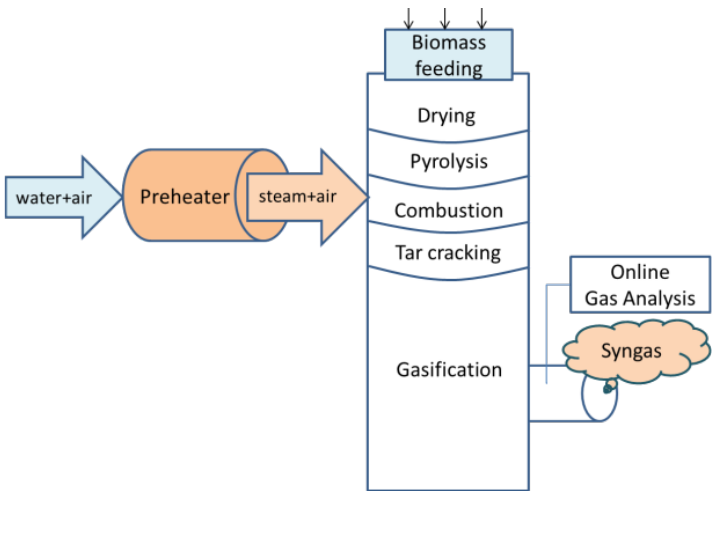
Figure 1. Scheme of the high temperature agent gasification (HTAG) system at KTH-Royal Institute of